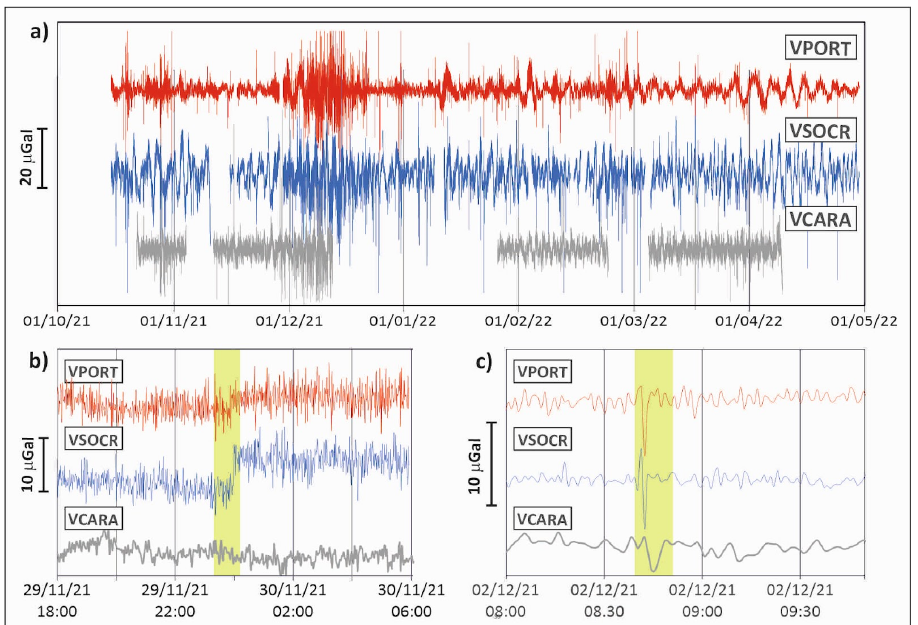
Figure 20. ( a ) Gravity signals observed at VPORT, VSOCR, and VCARA stations, from 15 October 2021 to 28 April 2022. Data are corrected for the effects of Earth tides, local atmospheric pressure changes, and instrumental drifts. ( b ) Twelve ‐ hour (time in UTC) gravity signals observed at VPORT, VSOCR, and VCARA stations from 29 to 30 November 2021. The yellow strip marks intervals where significant gravity variations with amplitudes of a maximum of about 15 μ Gal and a dominant pe ‐ riod over tens of minutes occurred at VPORT and VSOCR stations (see text for details). ( c ) One hundred and ten minutes (time in UTC) gravity signals, observed at VPORT, VSOCR, and VCARA